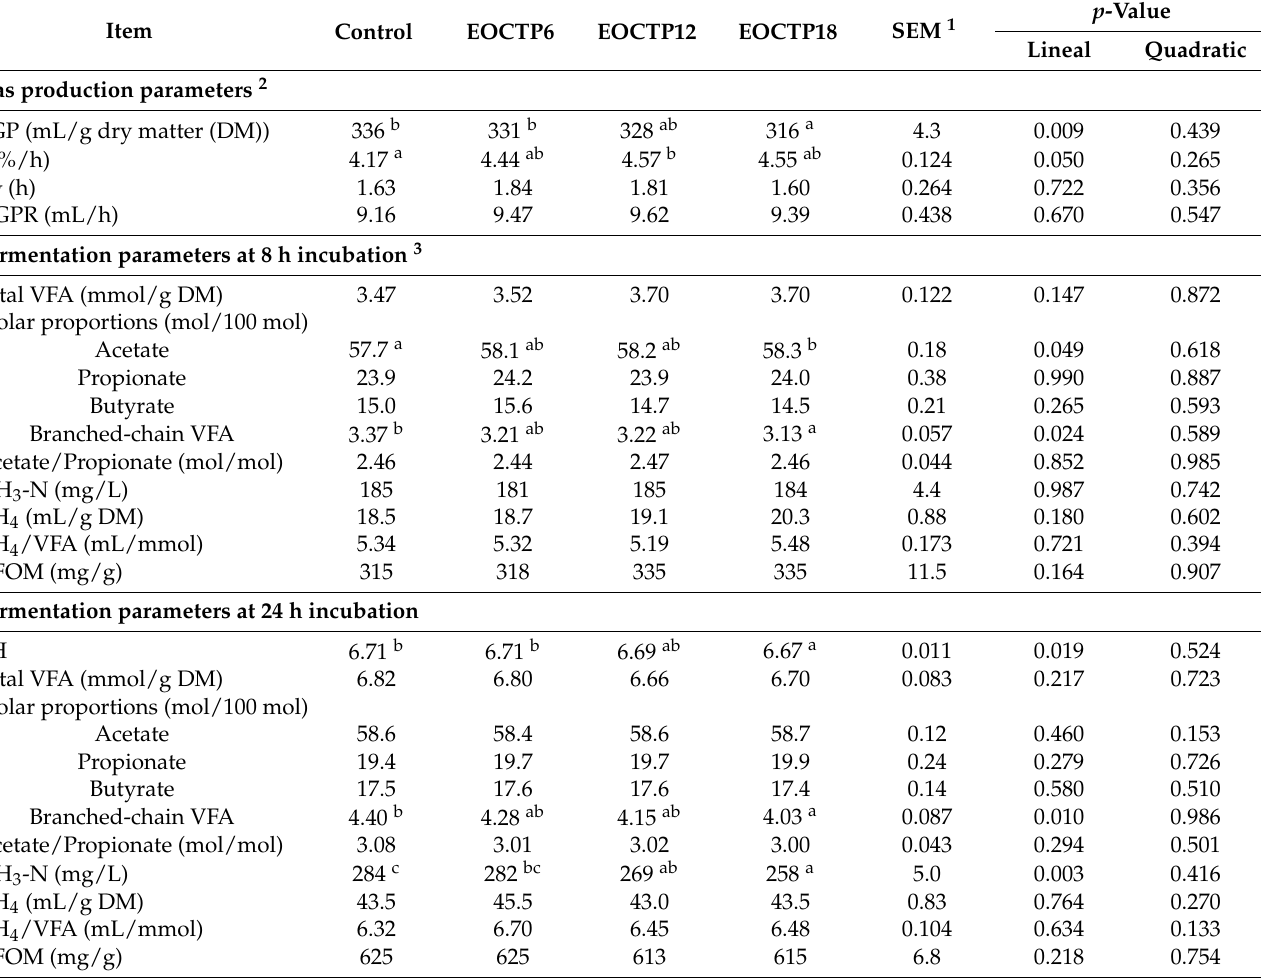
Table 5. Gas production parameters and fermentation parameters after 8 and 24 h of in vitro